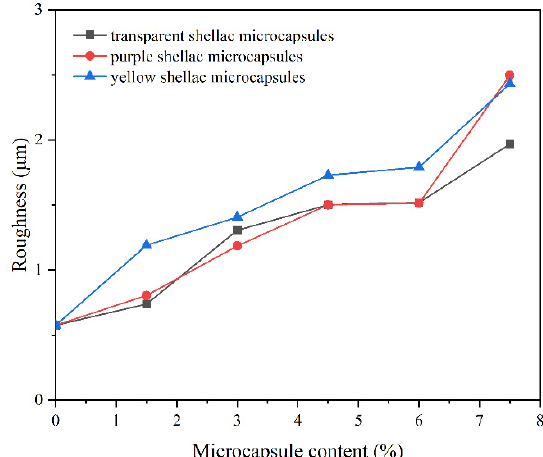
Figure 4. TheroughnessofthecoatingonBeliwoodwiththecontentofdifferentshellaccoremicrocapsules.